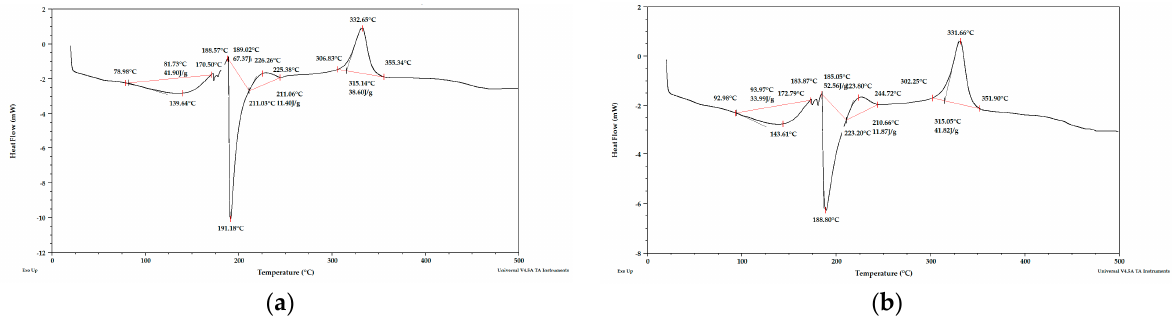
Figure 5. DSC curves for apple pomace dried to dry weight ( a ) sample 1, ( b ) sample 2. Analysis under nitrogen atmosphere.